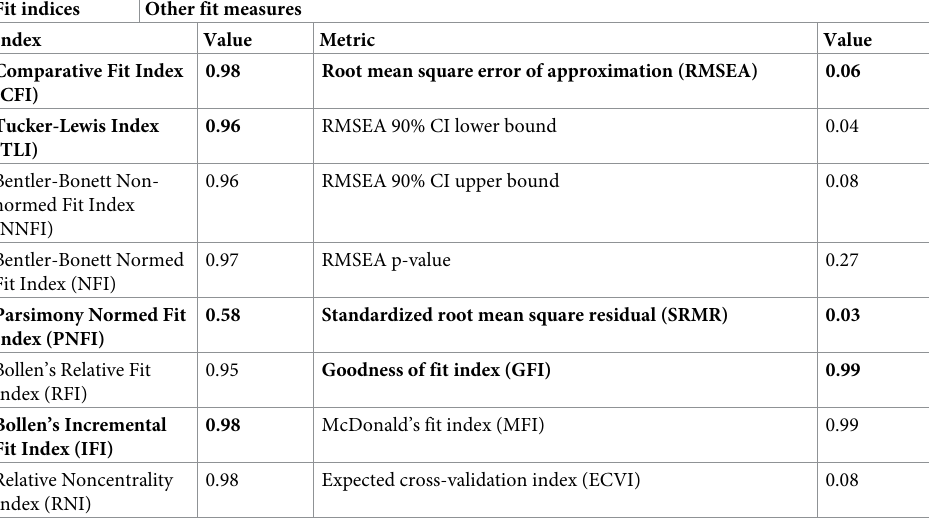
Table 2. Fit indices and fit metrics for the single factor BFAS containing proposed factor items.